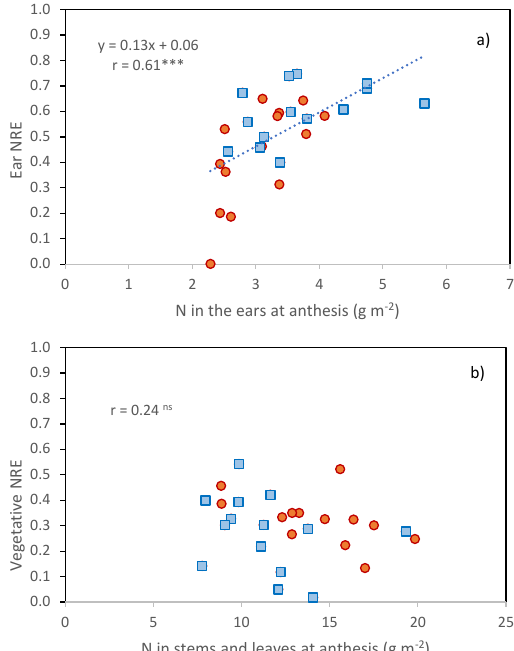
Figure 5. ( a ) Relationships between N remobilization indexes of ears and N content in the ears at anthesis; ( b ) Relationships between N remobilization indexes of vegetative organs (stems and leaves) and N content in vegetative organs at anthesis. Data are cultivar × year means (orange, 2016; blue, 2017). ns, Pearson correlation coefficient not significant; ***, Pearson correlation coefficient significant at p ≤ 0.001.